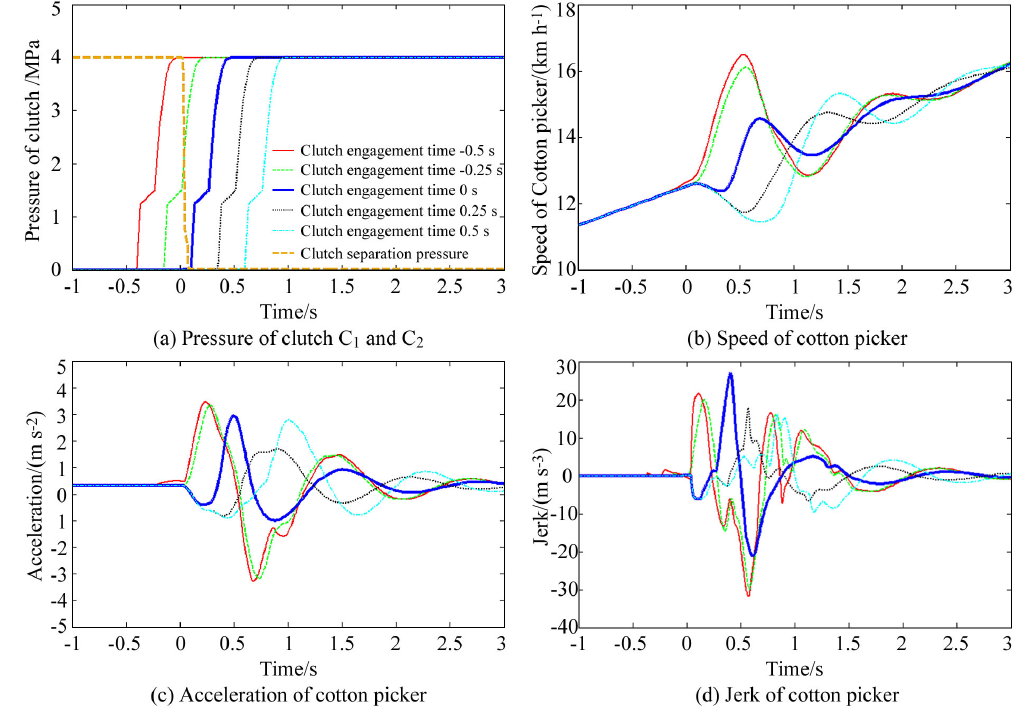
Figure 9. Influence of clutch engagement time on the shift quality of the cotton picker.